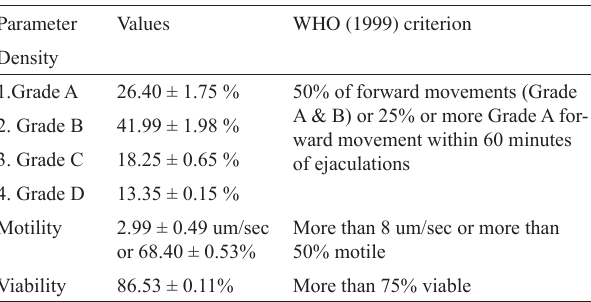
Table 1 - Sperm motility grading in this study compared to WHO (1999) recommendation